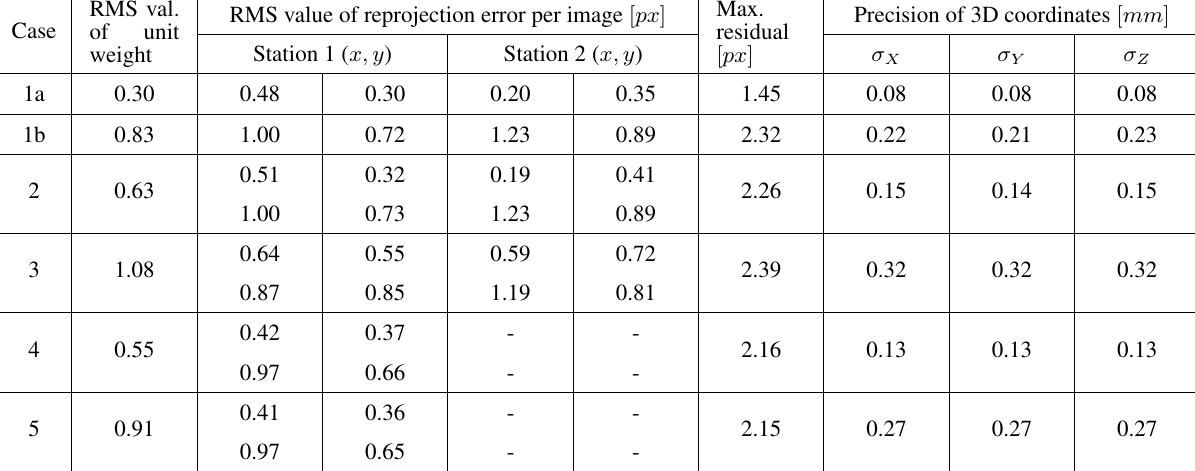
Table 2. Adjustment results. The first columns show the image-based data, namely the unit weight error of the adjustment (cid:112) Ω curr / ( n − u ) ; where n is the number of observations and u the number of unknowns), the reprojection errors, for each image ( separately and for all targets, gathered as one value by the root mean square (RMS), and the maximum residual (highest reprojection error in image plane) seen in the adjustment (in x or y , however not specified in table for each case). Upper values in the reprojection errors of different stations for cases 2 to 5 show results of the left camera, whereas lower values denote those of the right camera. The last three columns represent the 3D coordinate precisions of the GCPs and platform points as RMS of their uncertainties.